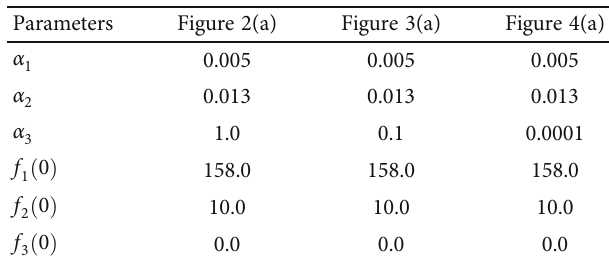
Table 1: The values of initial parameters conditions of the model (1) in Spain.